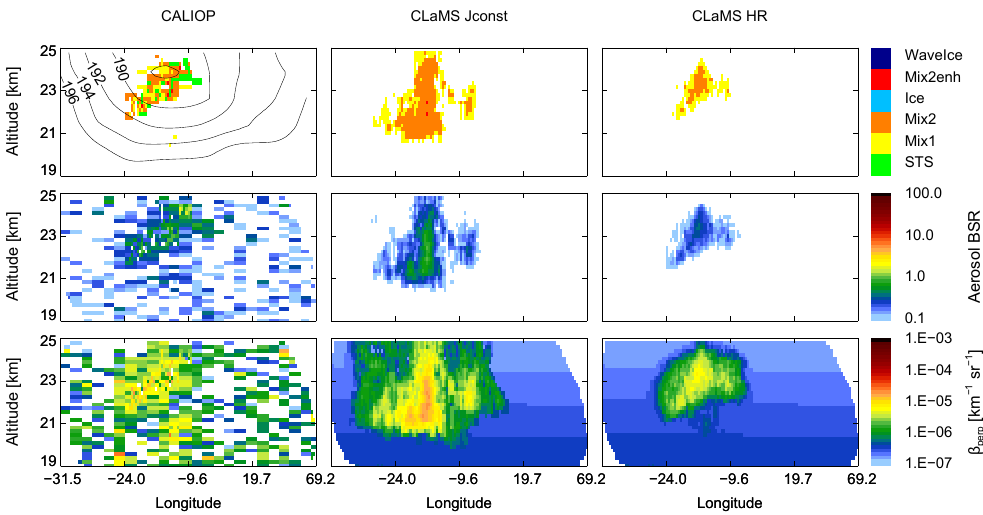
Fig. 6. CALIOP signals for one orbit segment on 21 December 2009, 04:54–04:55UTC and corresponding T-matrix calculations from CLaMS results. The plots of left column show the CALIOP data, whereas the corresponding CLaMS results for the runs Jconst and HR are shown in the middle and right columns, respectively. The panels in the top row show the particle classification after Pitts et al. (2009). The panels in the middle row correspond to the aerosol backscatter signal. The panels in the lower row correspond to the perpendicular backscatter signal. The temperature (K) from ERA-Interim is indicated by the contour lines in the top left